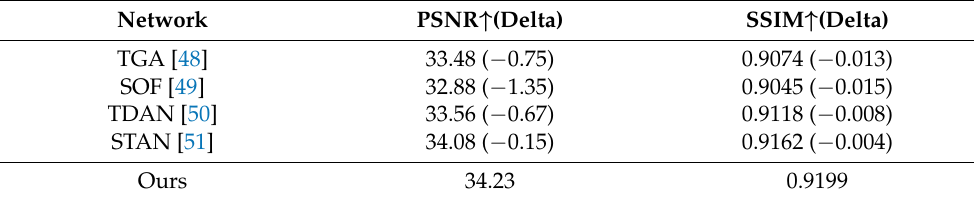
Table 8. Average PSNR (dB) and SSIM on the Vimeo-90K-T test